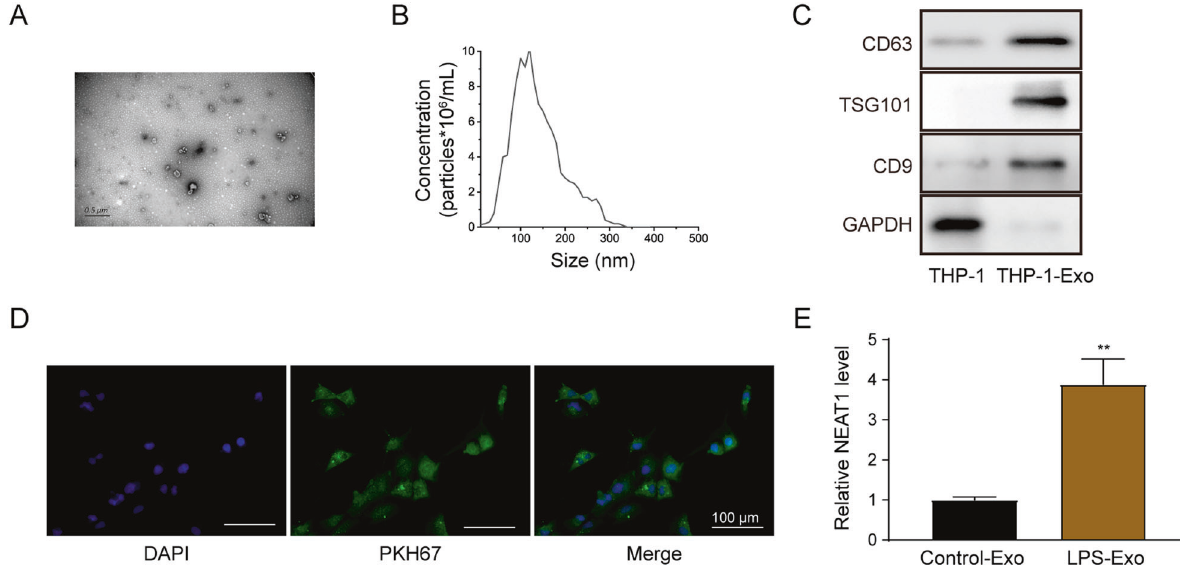
Fig. 1 NEAT1 expression is increased in exosomes derived from LPS-treated THP-1 macrophages. A , B Characterization of exosomes isolated from THP-1 macrophages using TEM ( A ) and NTA ( B ) analyses. C Western blot analysis of the expression levels of CD63, TS101, and CD9 in exosomes isolated from THP-1 macrophages. D The uptake of PKH67-labeled exosomes by LX-2 cells. Scale bar: 100 μ m. E qRT-PCR detection of the NEAT1 expression in exosomes isolated from LPS-treated THP-1 macrophages and non-treated macrophages. ** p <